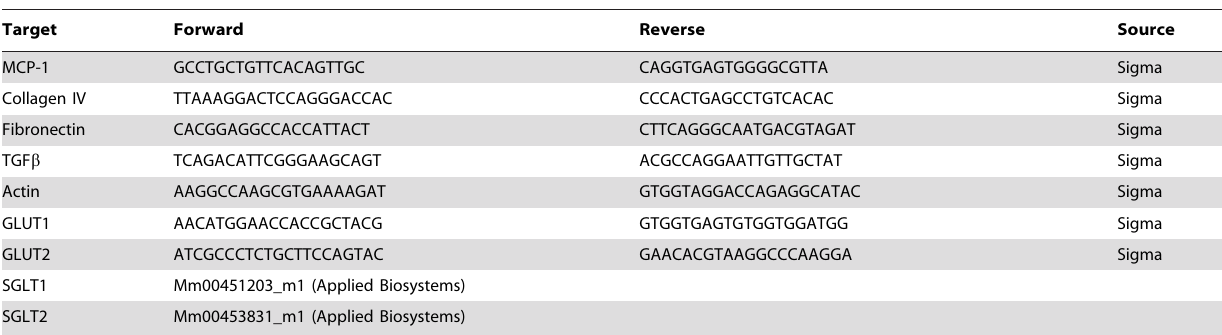
Table 2. PCR primer sequences.